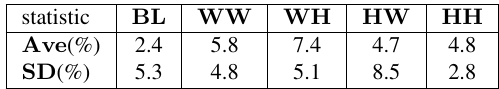
Table 1. Comparisons between the mean value of live pigs body measurements measured manually and using our software. Ave : average percent errors for different traits on the 10